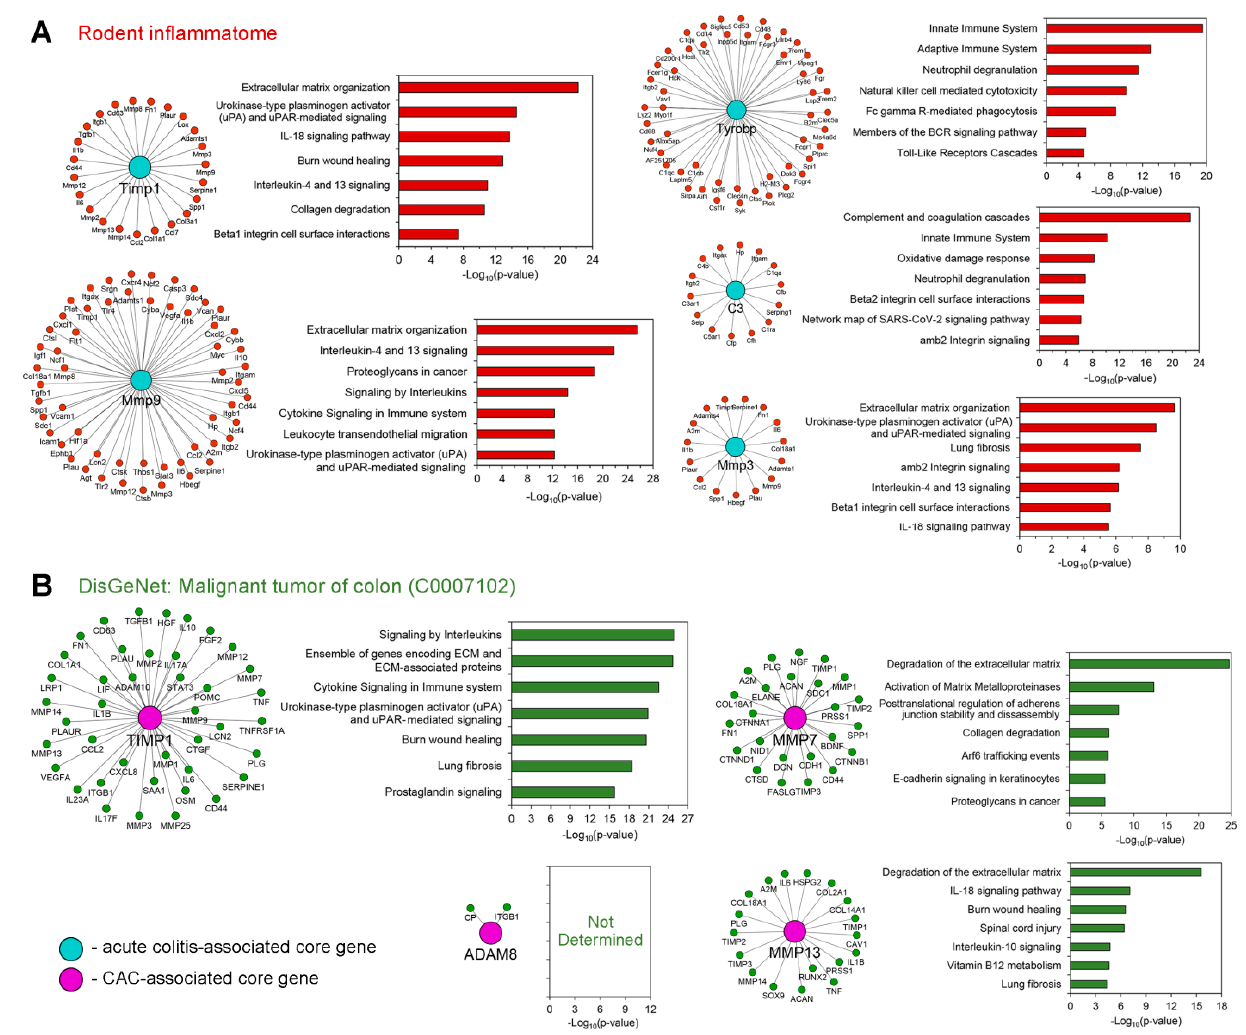
Figure 4. The involvement of the identified acute colitis- and CAC-related hub genes in murine inflammatome ( A ) and the gene network associated with malignant tumor of the colon, retrieved from DisGeNET ( B ). The modules containing the explored genes with their gene partners were extracted from gene networks created using the STRING database and visualized using Cytoscape, according to Section 4.3. Functional analysis of gene modules was performed using the ToppFun tool.